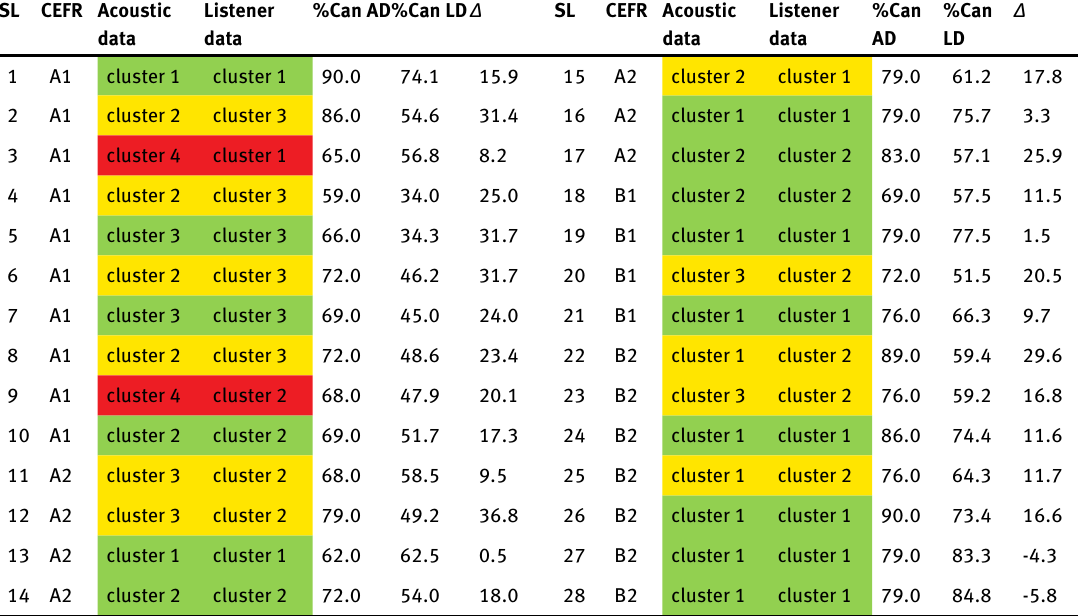
Table 14. Mismatch between the acoustic and listener results based on clustering, and on the average percentages of cano- nical classifications/transcriptions per Spanish learner with their corresponding CEFR language proficiency level, match (in green), mismatch of one cluster (in orange) and mismatch of two clusters (in red) are indicated; SL = Spanish learners, %Can = percentages of canonical classifications/transcriptions, AD = acoustic data, LD = listener data, Δ = difference between the average percentages of canonical classifications/transcriptions of the acoustic and listener